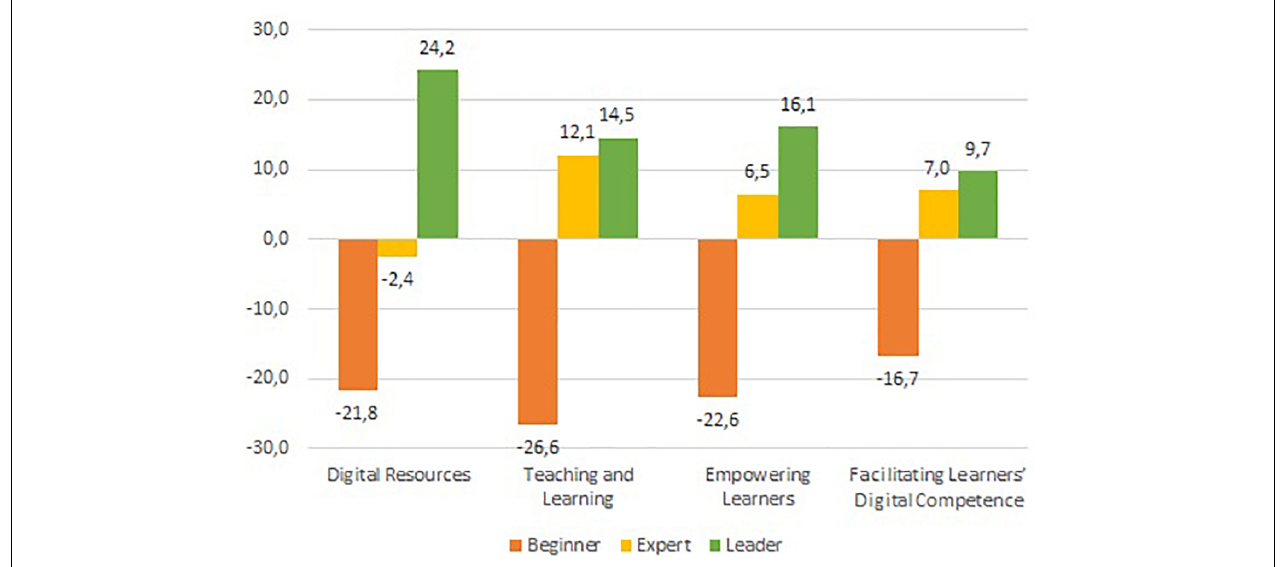
FIGURE 1 | Dynamics of Case 1 participants’ digital competences (increase in competence-level group sizes, by DigCompEdu area, in percentage points).